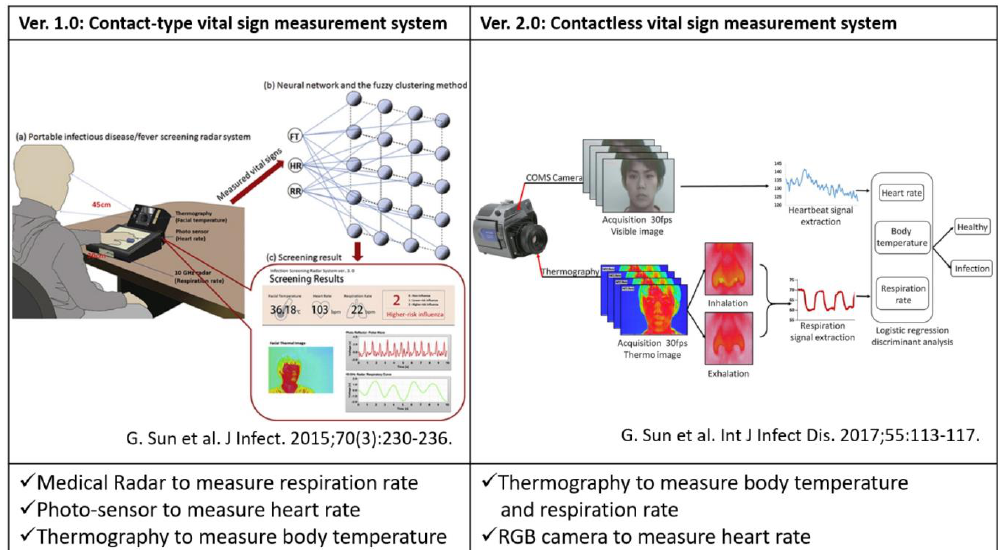
Figure 1. Contact and contactless vital sign measurement systems for infection screening. The figures were with copyright permission [8,10].